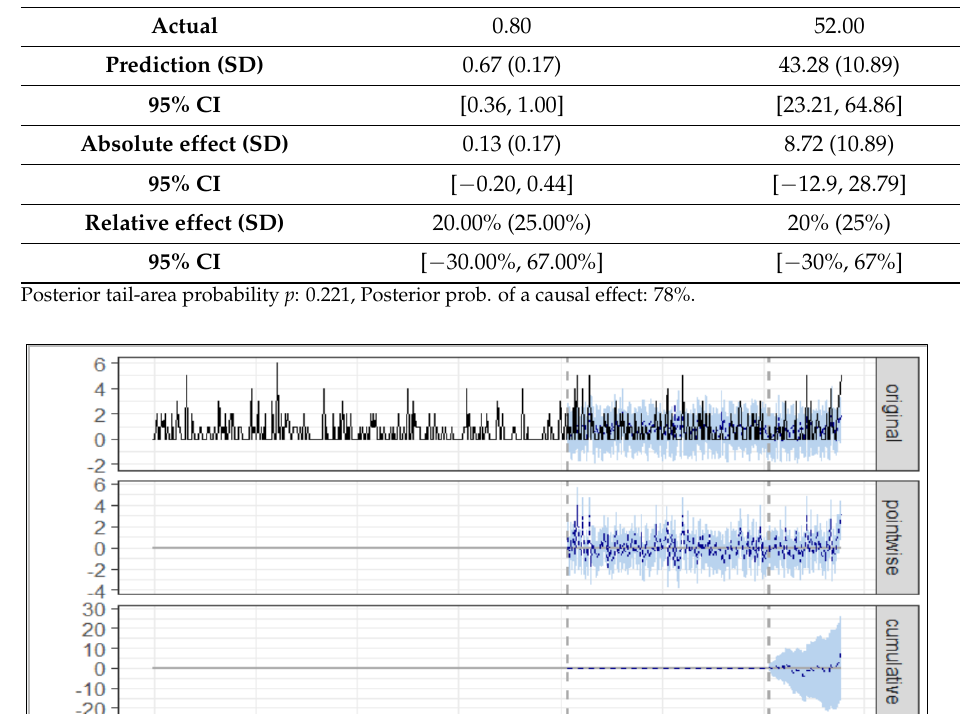
Table 2. Summary statistics — Causal Impact Analysis (post-intervention 1 vs. post intervention 2)